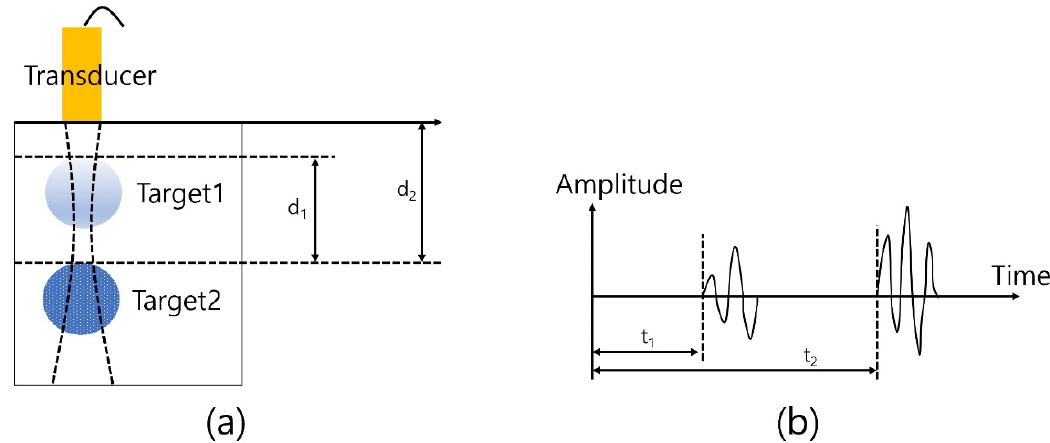
Figure 5. Principle of ultrasound imaging: ( a ) Target and transducer and ( b ) received signal from targets.